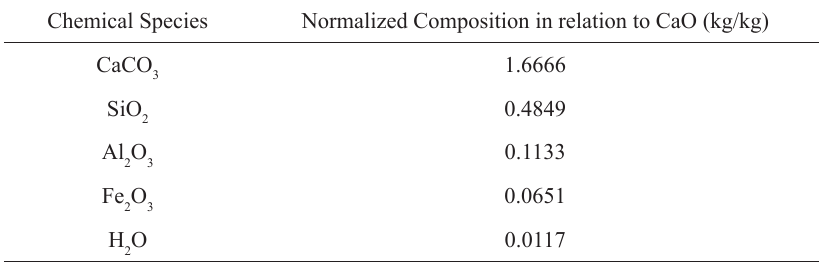
Input composition of the raw material in the rotary kiln reported by industry. Chemical Species Normalized Composition in relation to CaO